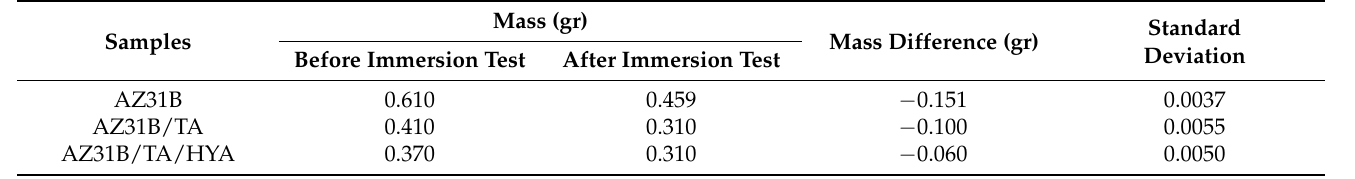
Table 9. Mass change data of each sample afterseven days of SBF immersion test.